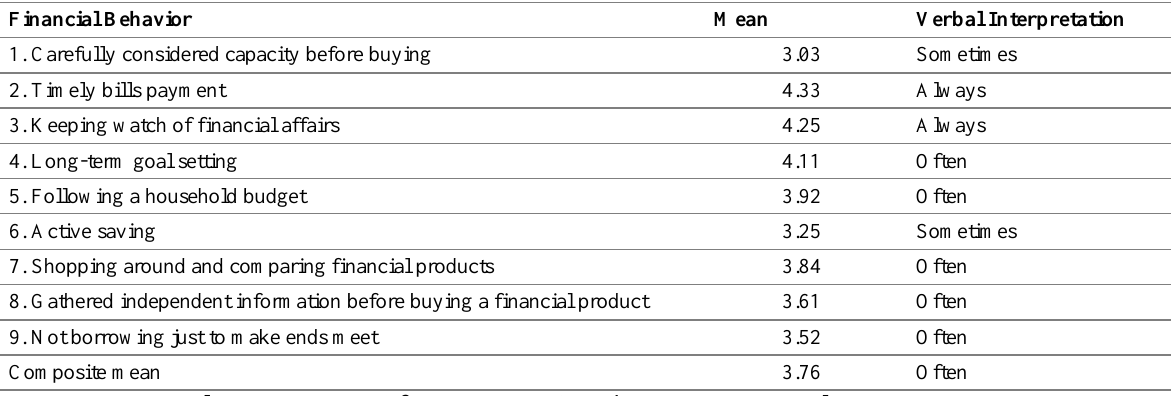
Table 5: Financial Behavior Observed by the respondents.